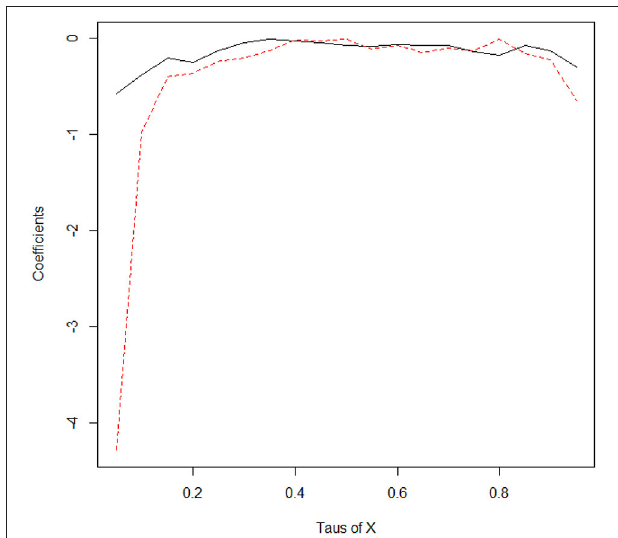
FIGURE 3 | The coefficients in different quantile from the estimation of quantile regression and quantile-on-quantile estimate. The black line indicates the estimates of coefficients in different quantiles for the quantile regression method. On the other hand, the dashed line indicates the coefficients’ estimates in different quantiles for the averaged quantile-on-quantile. X indicates healthcare